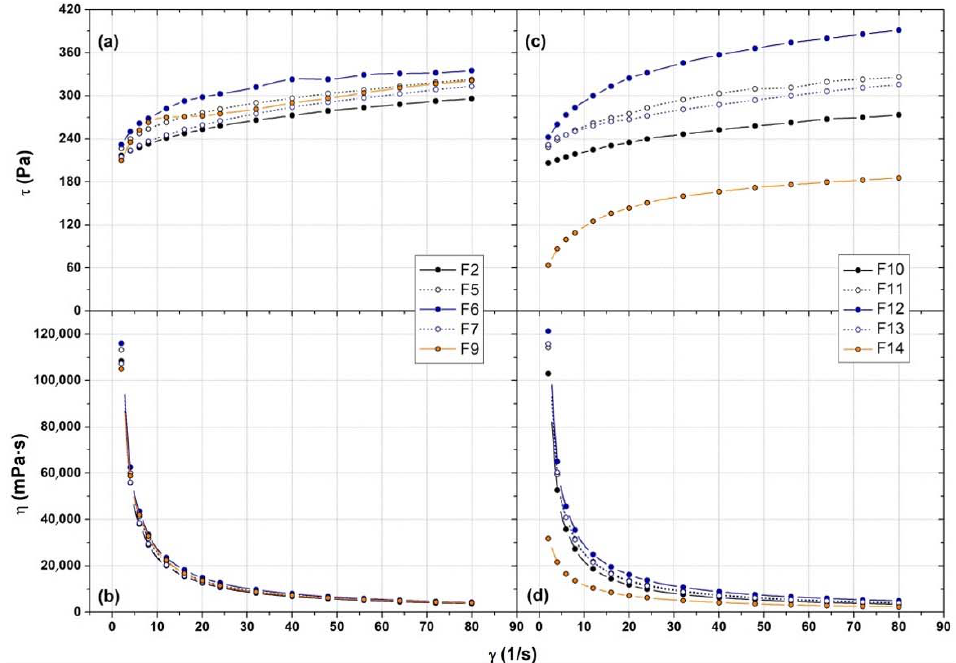
Figure 5. Dynamic viscosity evaluation of the formulations prepared in water ( a , b ) and in PBS 1 × ( c , d ) at different share rate at 35 ◦